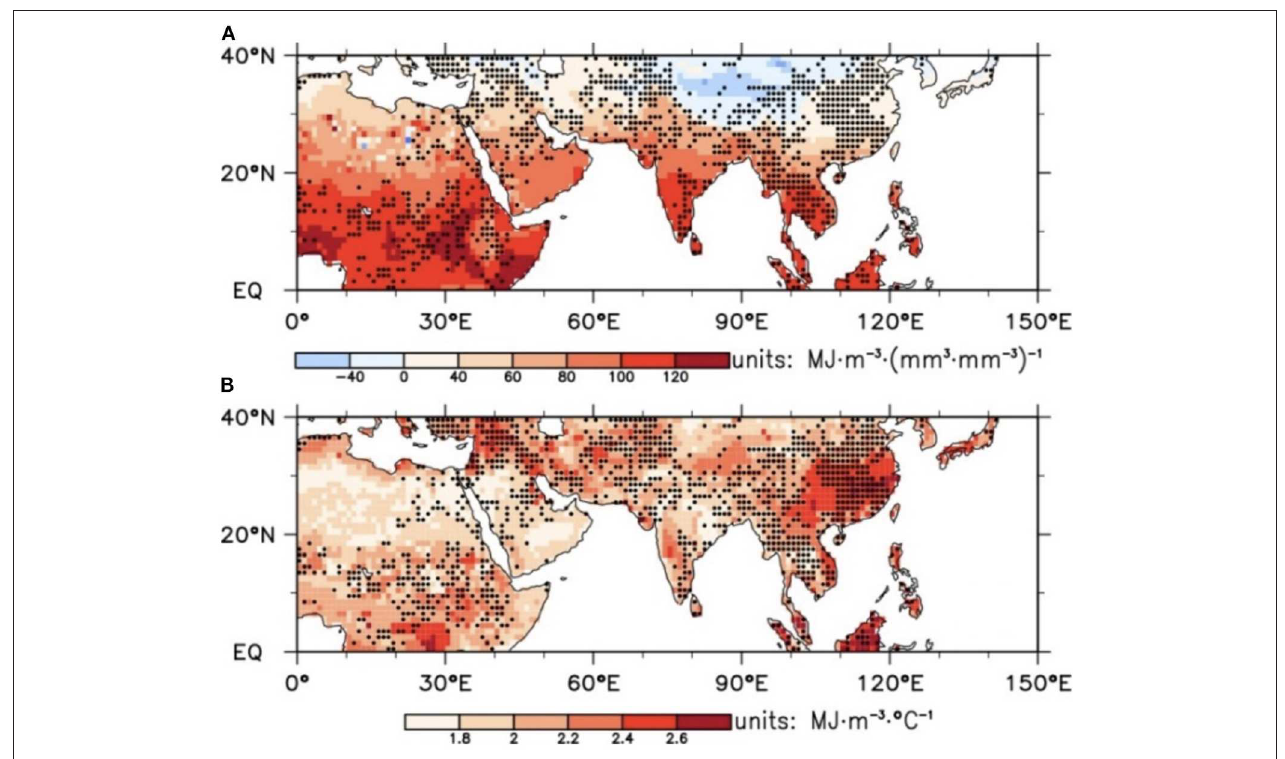
FIGURE 12 | The multiple linear regression (MLR) coefficients of soil enthalpy on (A) soil moisture and (B) soil temperature at mid-low latitudes using GLDAS2.0. The coefficients in the regions with solid black dots are statistically significant ( p < 0.05) after